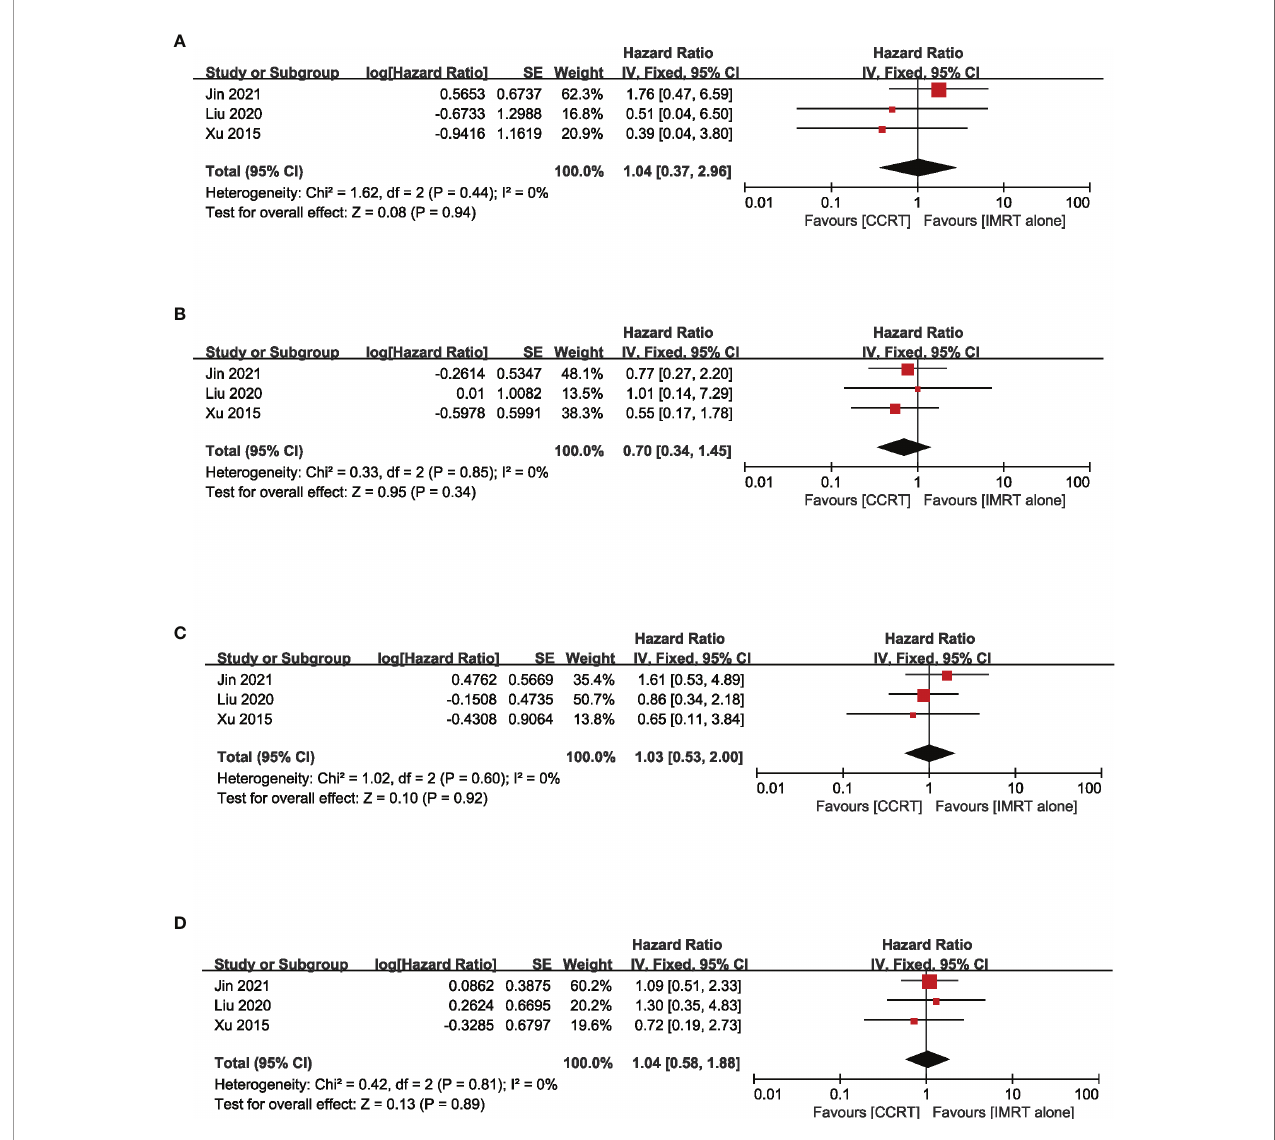
FIGURE 5 | Forest plot of the meta-analysis regarding OS (A) , LRFS (B) , DMFS (C) , and PFS (D) with CCRT vs. IMRT alone in the N1